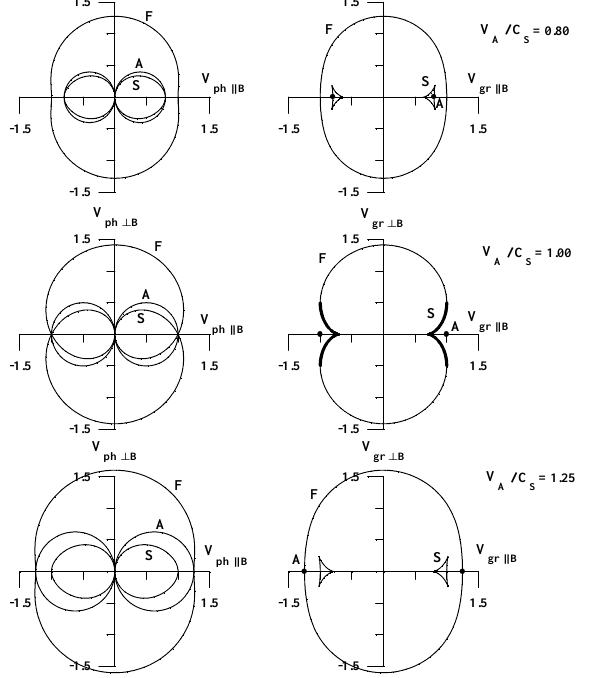
Fig. 2. Phase (left) and group (right) polar diagrams for MHD waves in three cases (from top to bottom): the sound speed in the medium is greater than, equal to or smaller than the Alfv´en speed. The group and phase velocities shown on the diagrams are nor- malised by the sound speed.